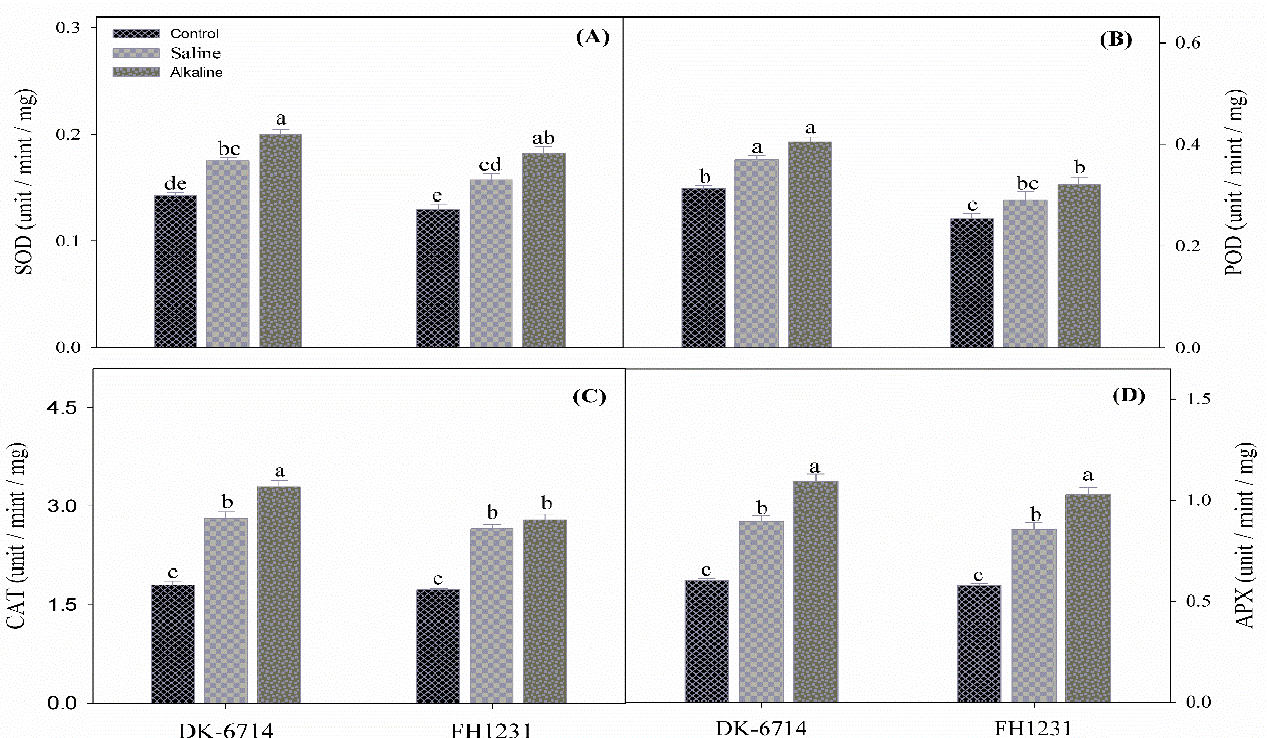
Figure 6. Effect of salinity and alkalinity stress on ( A ) superoxide dismutase (SOD), ( B ) peroxidases (POD), ( C ) catalase (CAT), and ( D ) ascorbate peroxidase (APX) activities in 20-day-old maize seedlings of two hybrids (DK-6714 and FH-1231). The bars represent the standard error (SE) of the four replicates. Similar small letters above bars represent nonsignificant (ns) differences among treatments ( p ≤ 0.05).